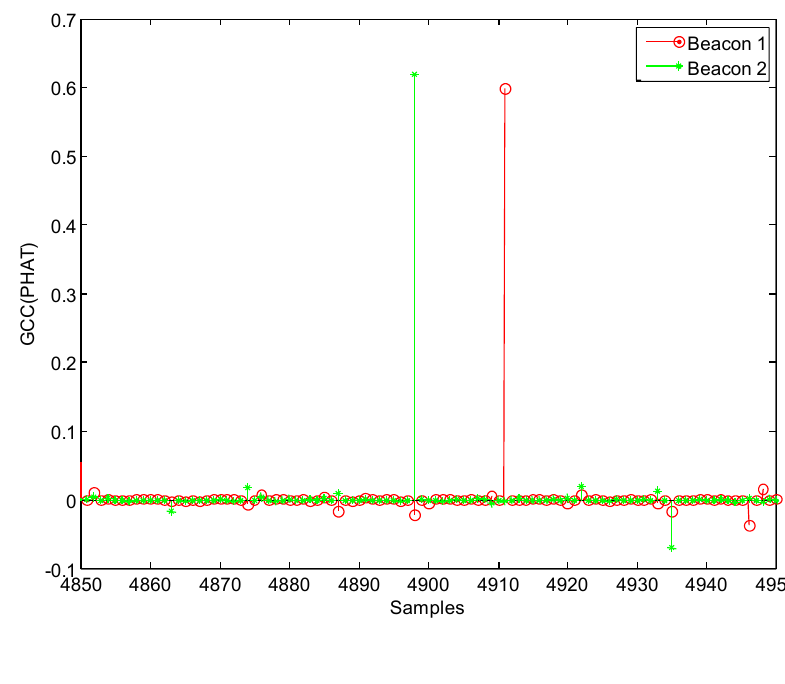
Figure 10. Beacon detection by applying generalised cross-correlation (GCC) with PHAT filtering, for a modulation symbol formed by four carrier cycles ( m = 4).